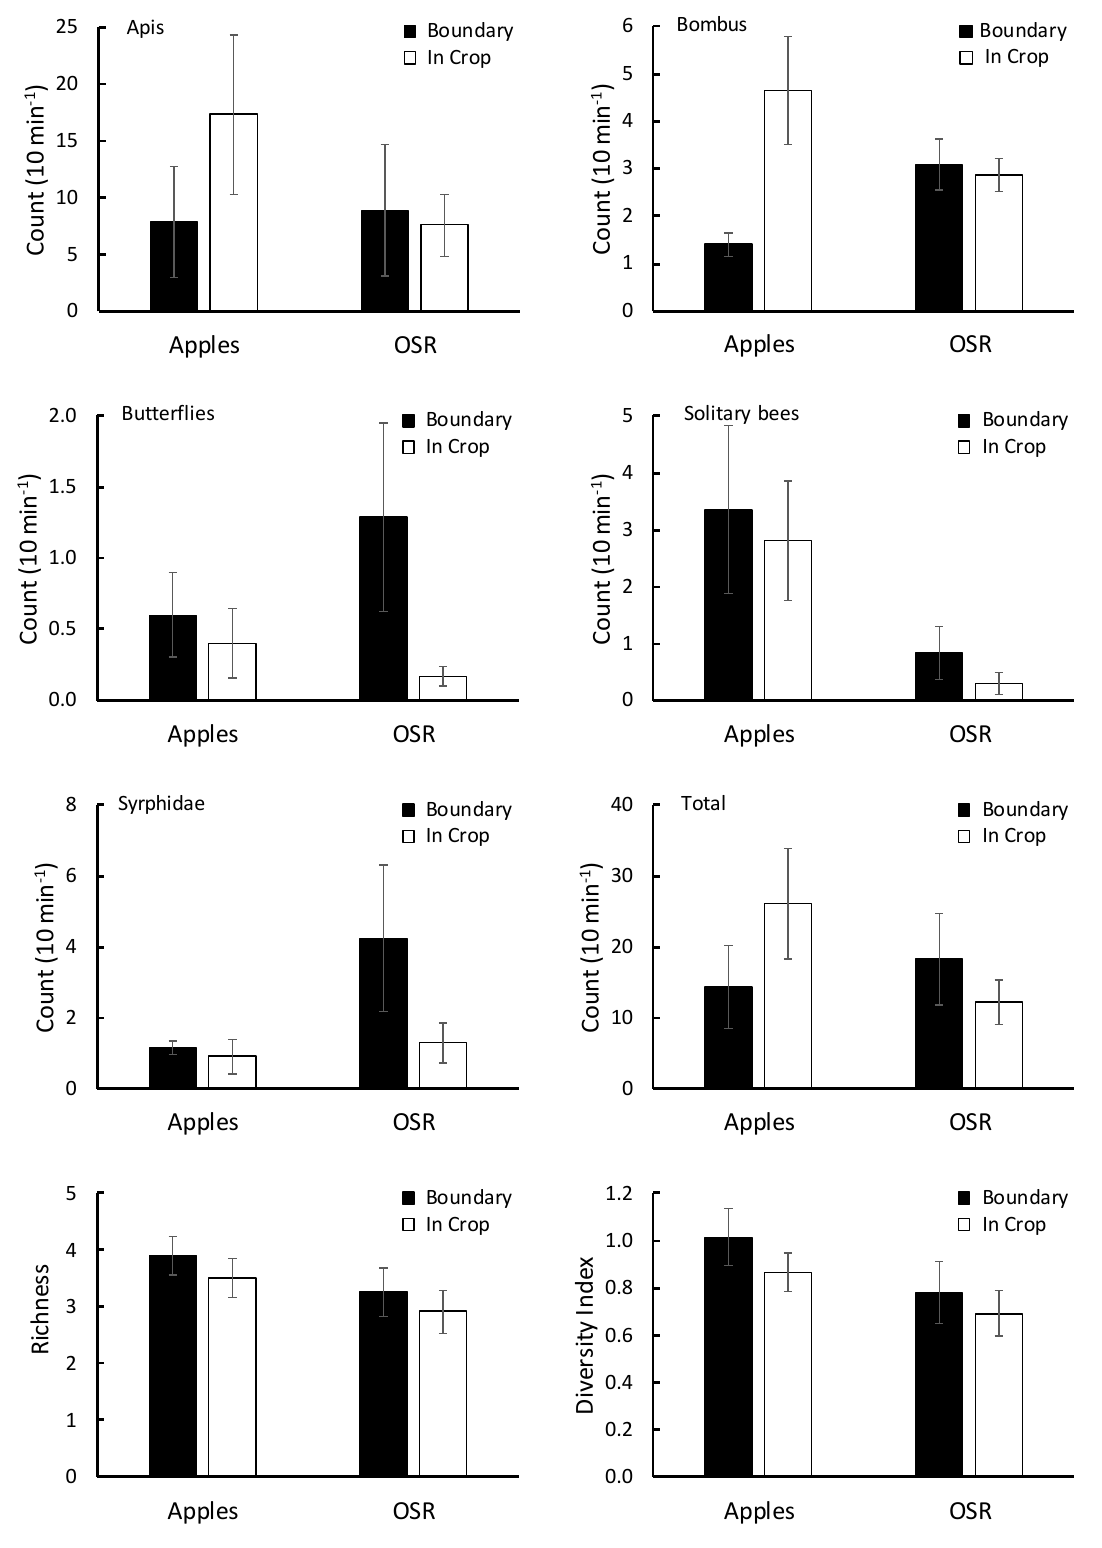
Figure 2. Abundance and diversity (mean ± SE) of pollinating insects in the centre of the main crop and in the field margins during flowering of OSR ( n = 6) and apples ( n =